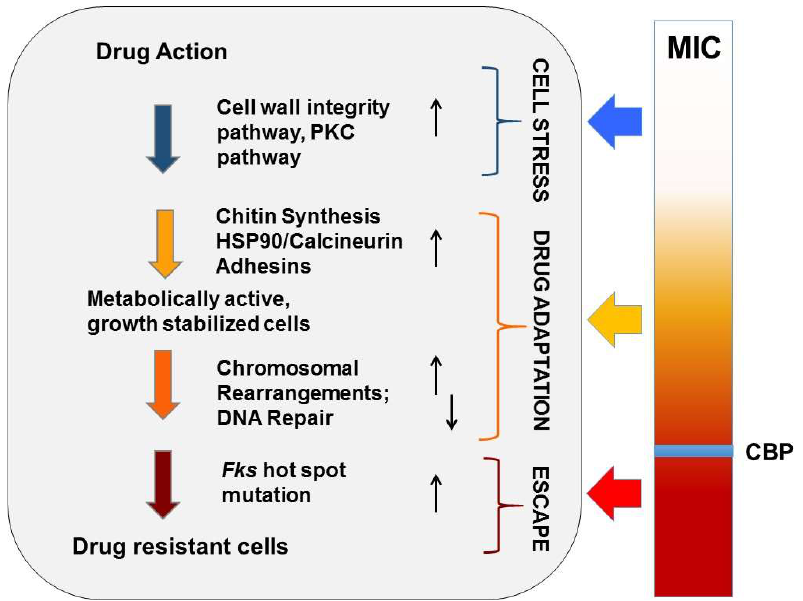
Figure 2. Evolution of echinocandin resistance. Cellular factors that influence the ability of yeast to adapt to echinocandin drug pressure are represented in a multistep model of resistance. Steps include initial cellular stress, drug adaptation, and genetic escape ( FKS mutation). The clinical breakpoint (CBP) of a species is the MIC measured prior to the formation of FKS escape mutants.